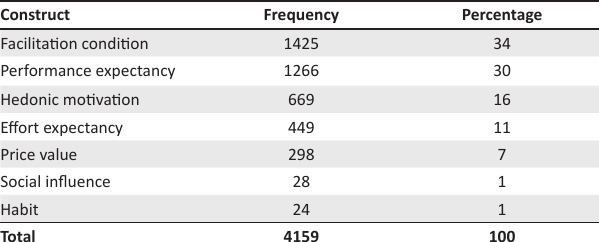
TABLE 1: Review categories. Construct